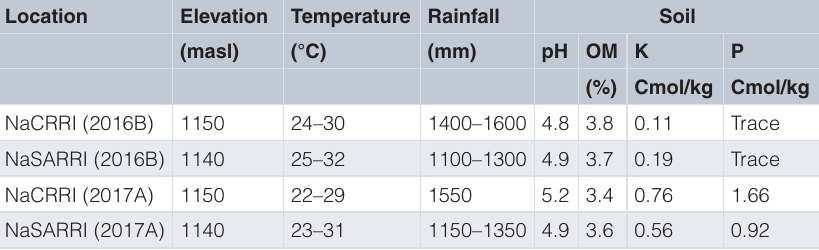
Table 3. Description of study sites used for screening sweetpotato genotypes for continuous storage root formation and bulking in Uganda.